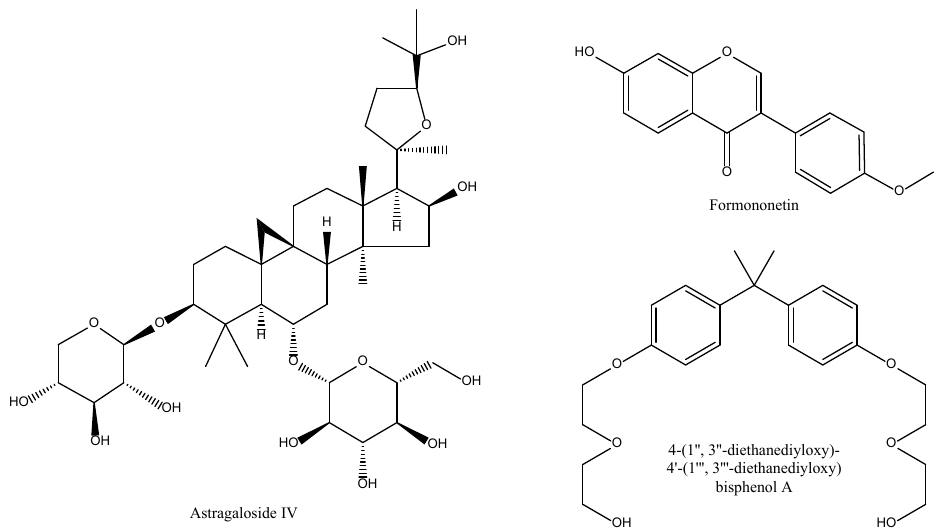
Figure 5. Bioactive anti-inflammatory (eicosanoid inhibition) and antioxidant principles from A. sinensis.